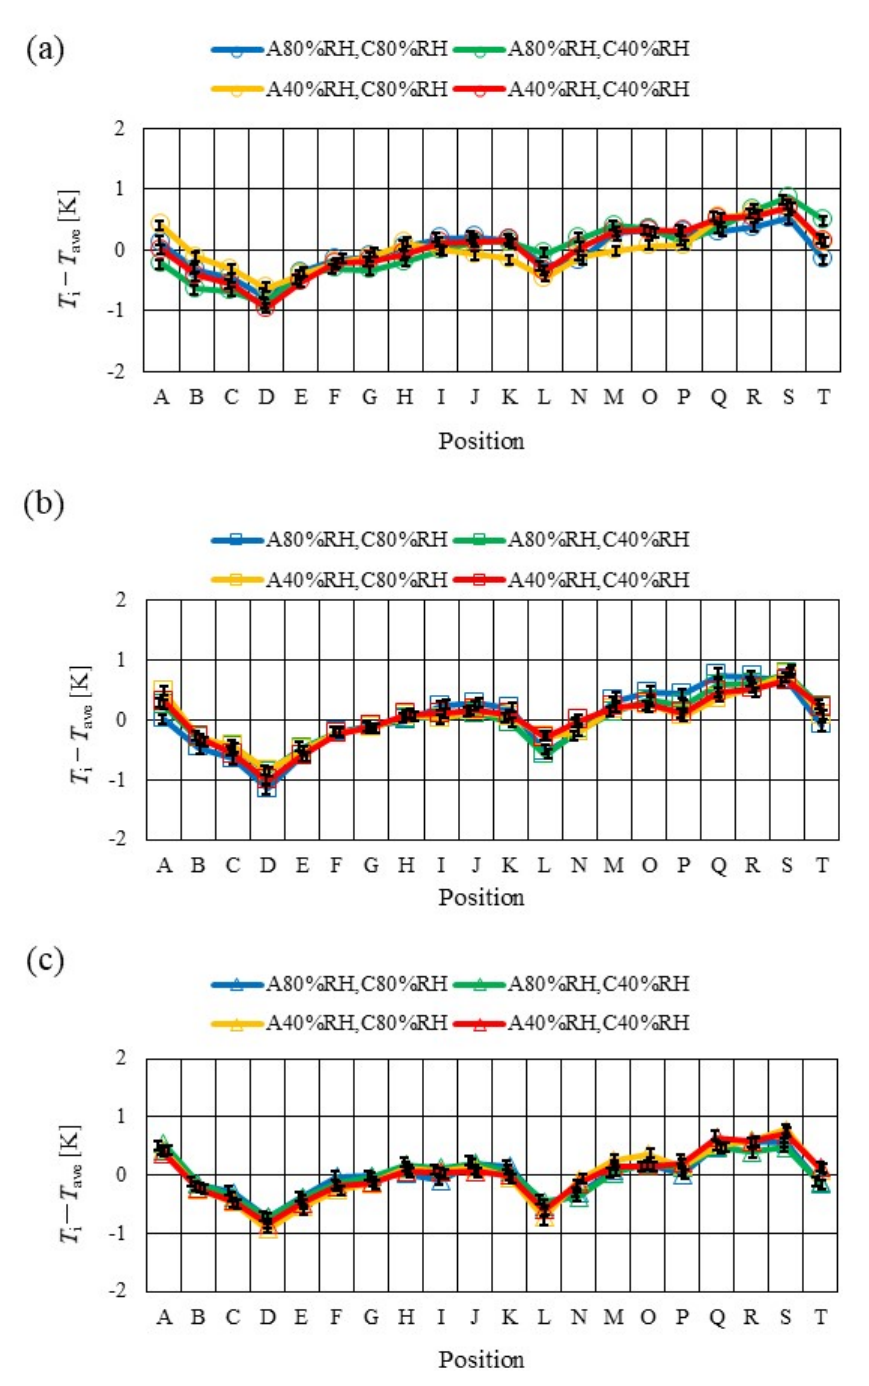
Figure 16. Comparison of in-plane temperature distributions at the cathode side among different RHs in the case of the separator thickness of 2.0 mm: ( a ) T init = 353 K; ( b ) T init = 363 K; ( c ) T init = 373 K.